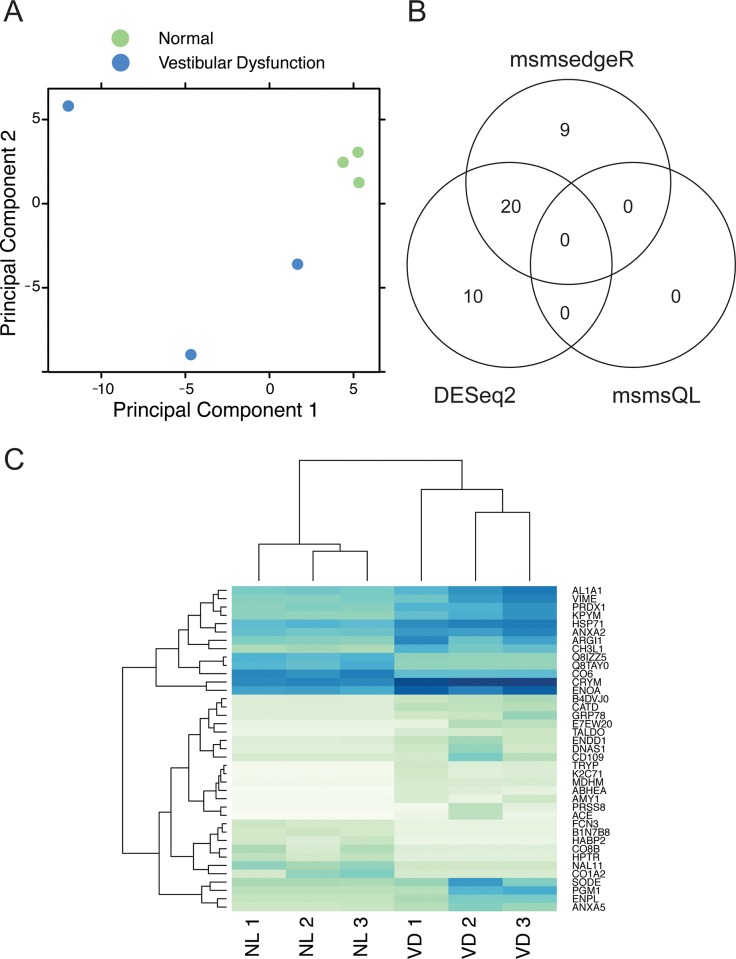
Proteomic analysis of human perilymph.(A) Principal component analysis (PCA) of the normalized and log-transformed spectral count matrix from the 6 samples of perilymph, including 3 from patients with normal hearing (pseudocolored green) and 3 from patients with severe vestibular dysfunction (pseudocolored blue). Tight clustering is observed among the clinically normal samples but the vestibular dysfunction samples appear quite heterogeneous. (B) Venn diagram of differentially expressed proteins identified by each differential expression analysis approach (DESeq2, msmsedgeR and msmsQL). (C) Heat map of proteins differentially expressed between perilymph obtained from patients with clinically normal hearing (NL 1, NL 2, and NL 3) versus those from patients with severe vestibular dysfunction (VD 1, VD 2, and VD 3). Darker blues indicate higher spectral counts. For assembly of the proteome of normal human perilymph, sample NL3 was excluded as it was obtained from a patient with an intracananicular meningioma.